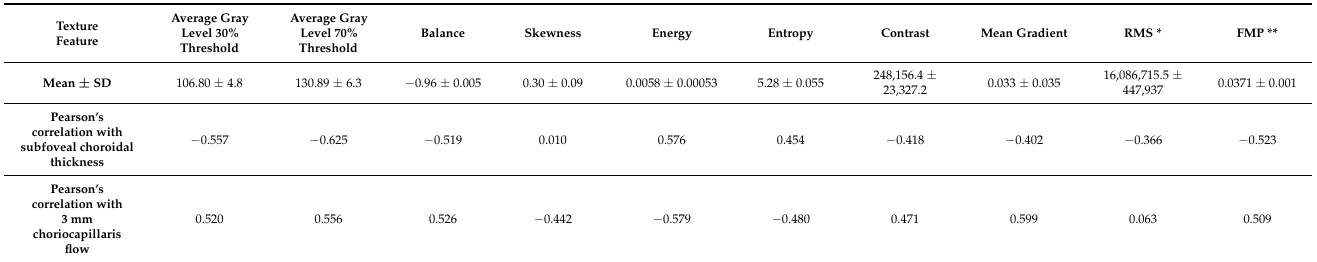
Table 1. Mean and standard deviation from the mean of each texture metric and correlation with established choroidal biomarkers.